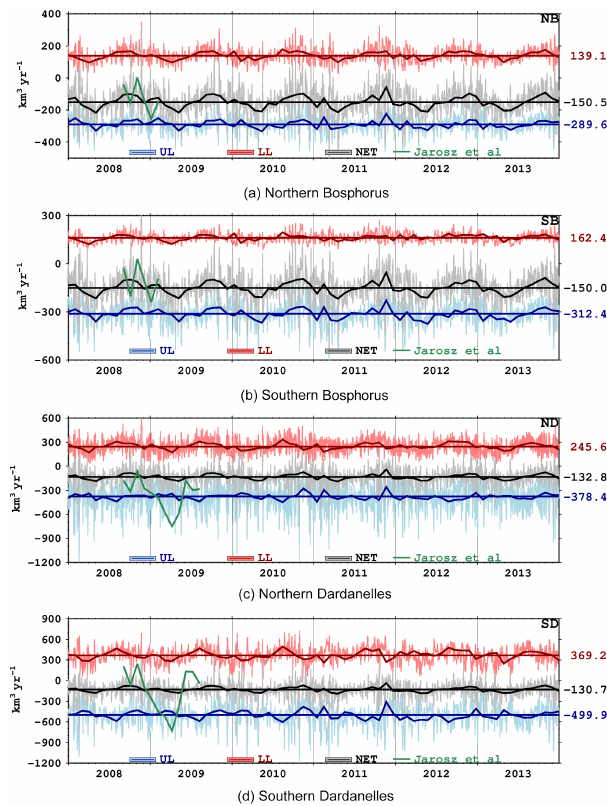
Figure 14. Daily upper layer (blue, UL), lower layer (red, LL) and net (grey, NET) volume fluxes through northern Bosphorus (NB), southern Bosphorus (SB), northern Dardanelles (ND) and southern Dardanelles (SD) in km 3 yr − 1 . Monthly and 6-year averages are overlaid with a darker tone of the same colour. The monthly aver- ages of volume fluxes computed by Jarosz et al. (2011b, 2013) are shown in green for the period of observations.